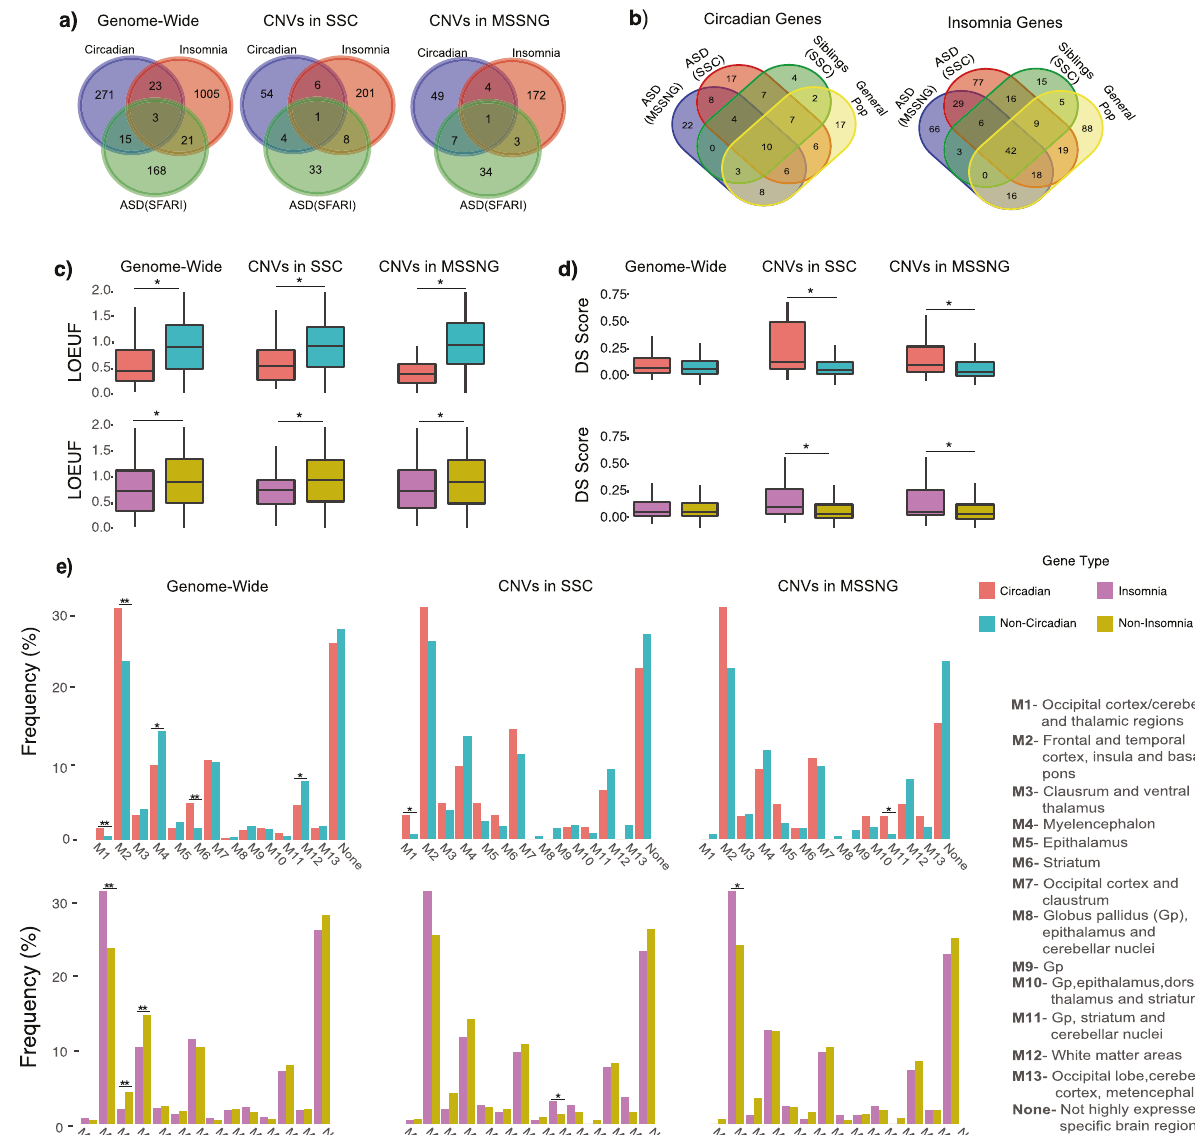
Fig. 2 Sleep risk gene characteristics. a Overlaps between insomnia risk, circadian pathway and ASD risk genes are depicted across the genome and for genes identi fi ed in SSC and MSSNG ASD cohorts. b Overlap between insomnia risk and circadian pathway genes encompassed in CNV ’ s in each cohort. c LOEUF score comparisons between insomnia risk and circadian pathway genes are depicted across the genome and for genes identi fi ed in SSC and MSSNG ASD cohorts. Mann – Whitney-U tests were applied for statistical comparisons. d DS score comparisons between insomnia risk and circadian pathway genes are depicted across the genome and for genes identi fi ed in SSC and MSSNG ASD cohorts. Mann – Whitney-U tests were applied for statistical comparisons. e Brain module comparisons between insomnia risk and circadian pathway genes are depicted across the genome and for genes identi fi ed in SSC and MSSNG ASD cohorts. Modules provide the locations brain regions where gene expression is concentrated (see legend). Binomial linear regressions were used to compare modules and FDR corrections were